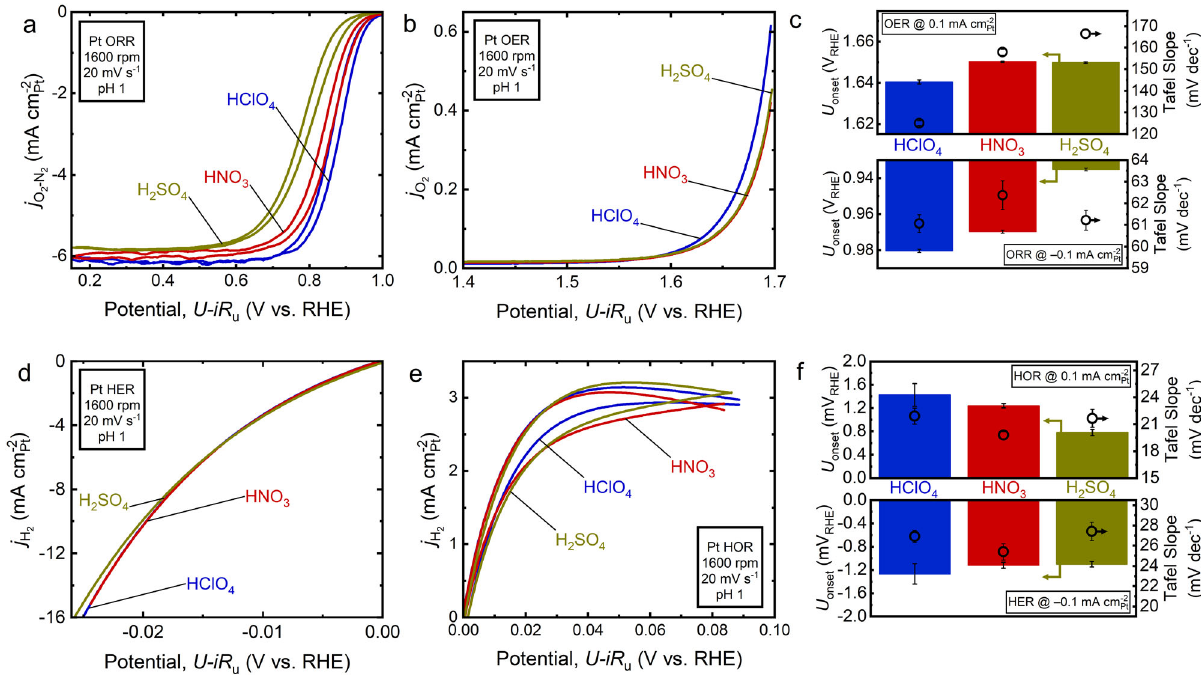
Fig. 2 Evaluation of Pt for oxygen and hydrogen electrocatalysis in HClO 4 , HNO 3 , and H 2 SO 4 . a Representative third-cycle-averaged N 2 -subtracted oxygen reduction reaction (ORR) rotating disk electrode (RDE) cyclic voltammogram (CV) of the Pt disk in pH 1 HClO 4 , HNO 3 , and H 2 SO 4 . b Representative second-cycle-averaged oxygen evolution reaction (OER) RDE CV of the Pt disk in pH 1 HClO 4 , HNO 3 , and H 2 SO 4 (OER trend is consistent as a function of cycle, Supplementary Fig. 4). c Average OER (top) and ORR (bottom) onset potential (bars, left y -axis) ± 0.1 mA cm (cid:1) 2 for all three acids and average Tafel geo slope (circles, right y -axis) in the low current density region. d Representative third-cycle-averaged hydrogen evolution rection (HER) RDE CV of the Pt disk in pH 1 HClO 4 , HNO 3 , and H 2 SO 4 . e Representative third-cycle-averaged hydrogen oxidation reaction (HOR) RDE CV of the Pt disk in pH 1 HClO 4 , HNO 3 , and H 2 SO 4 . f Average HOR (top) and HER (bottom) onset potential (bars, left y -axis) ± 0.1 mA cm (cid:1) 2 for all three acids and average Tafel slope (circles, right geo y-axis) in the low current density region. Error bars represent the standard deviation of separate triplicate measurements. All CVs collected at 1600 rpm, 20mVs – 1 , and iR u corrected. Color code: HClO 4 (blue), HNO 3 (red), and H 2 SO 4